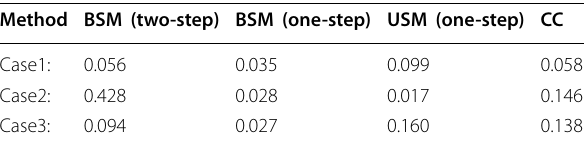
The same as that of Table